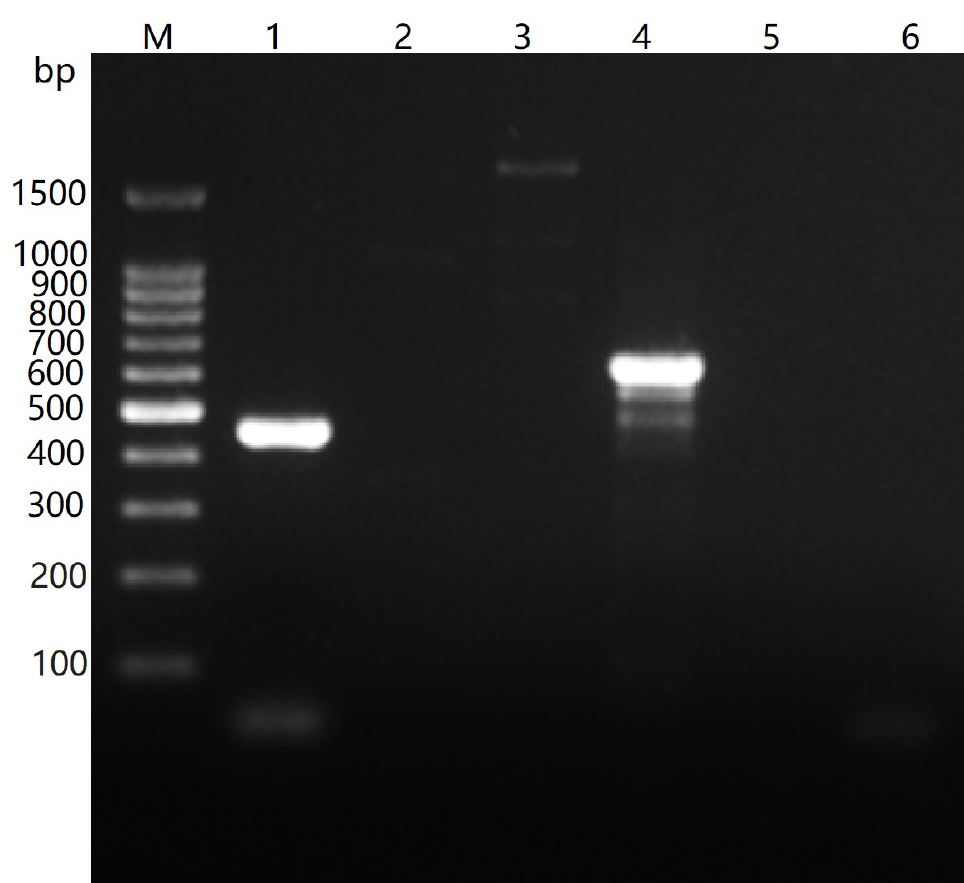
Figure 6. Identification species and capsular serotypes of the isolated bacteria by PCR. M: DNA Ladder; 1: Species specific gene; 2~6: Capsular serotype A, B, D, E and F.